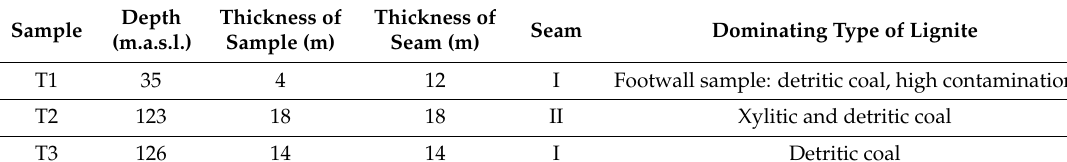
Table 1. Details of lignite samples.